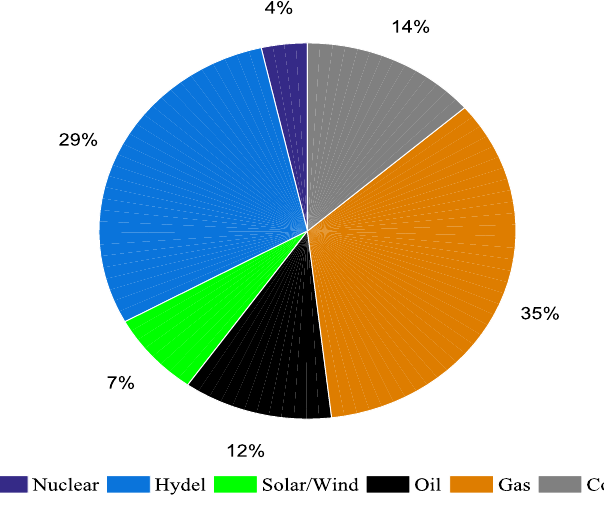
Figure 1. Power generation capacity F.Y 2017-18.